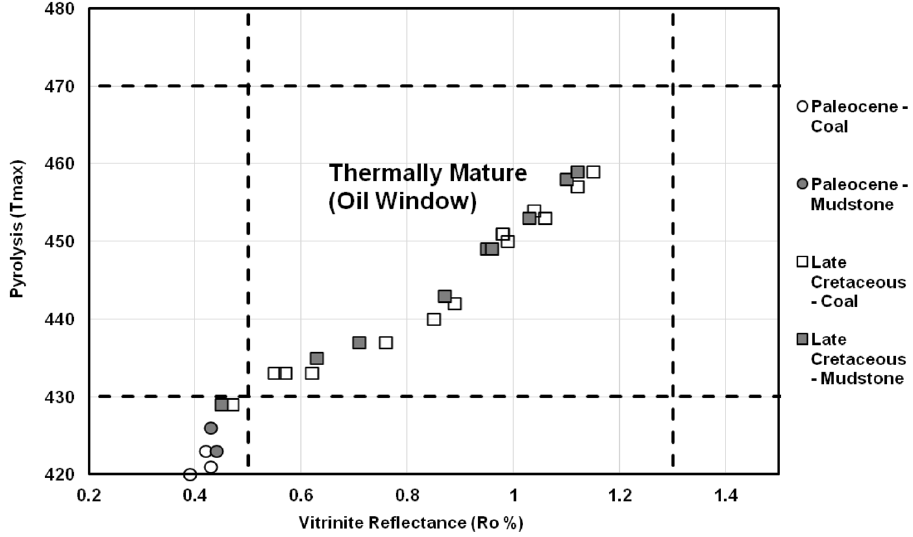
Fig. 8 A cross-plot of maxi- mum pyrolysis temperature ( T max ) versus vitrinite reflec- tance (% R o ) to indicate source rock thermal